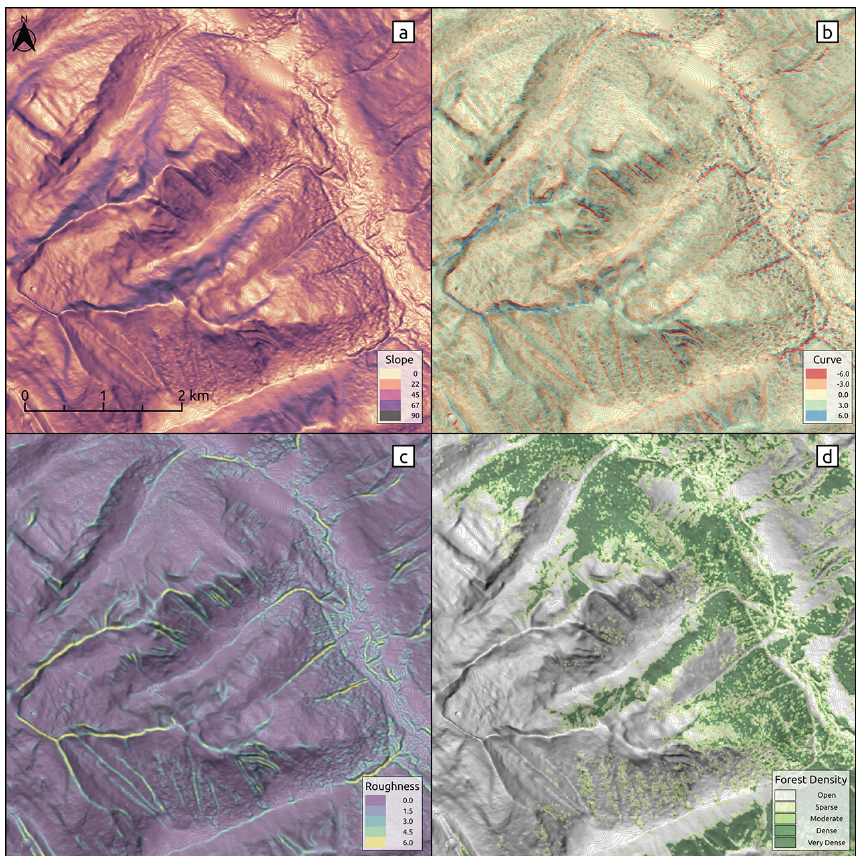
Figure 7. PRA model input parameters. Slope angle, curvature, and ruggedness derived from the DEM (a–c) and forest density derived from the forest mask (d) . Forest data created using Planet Labs RapidEye imagery (Planet Team, 2017). Table 1. Grid search input parameter values. Optimized input parameters indicate that the grid search led us to change the default input parameter to a value that improved the PRA model accuracy for our study area. Input parameter Range Interval Default Optimized Slope angle minimum